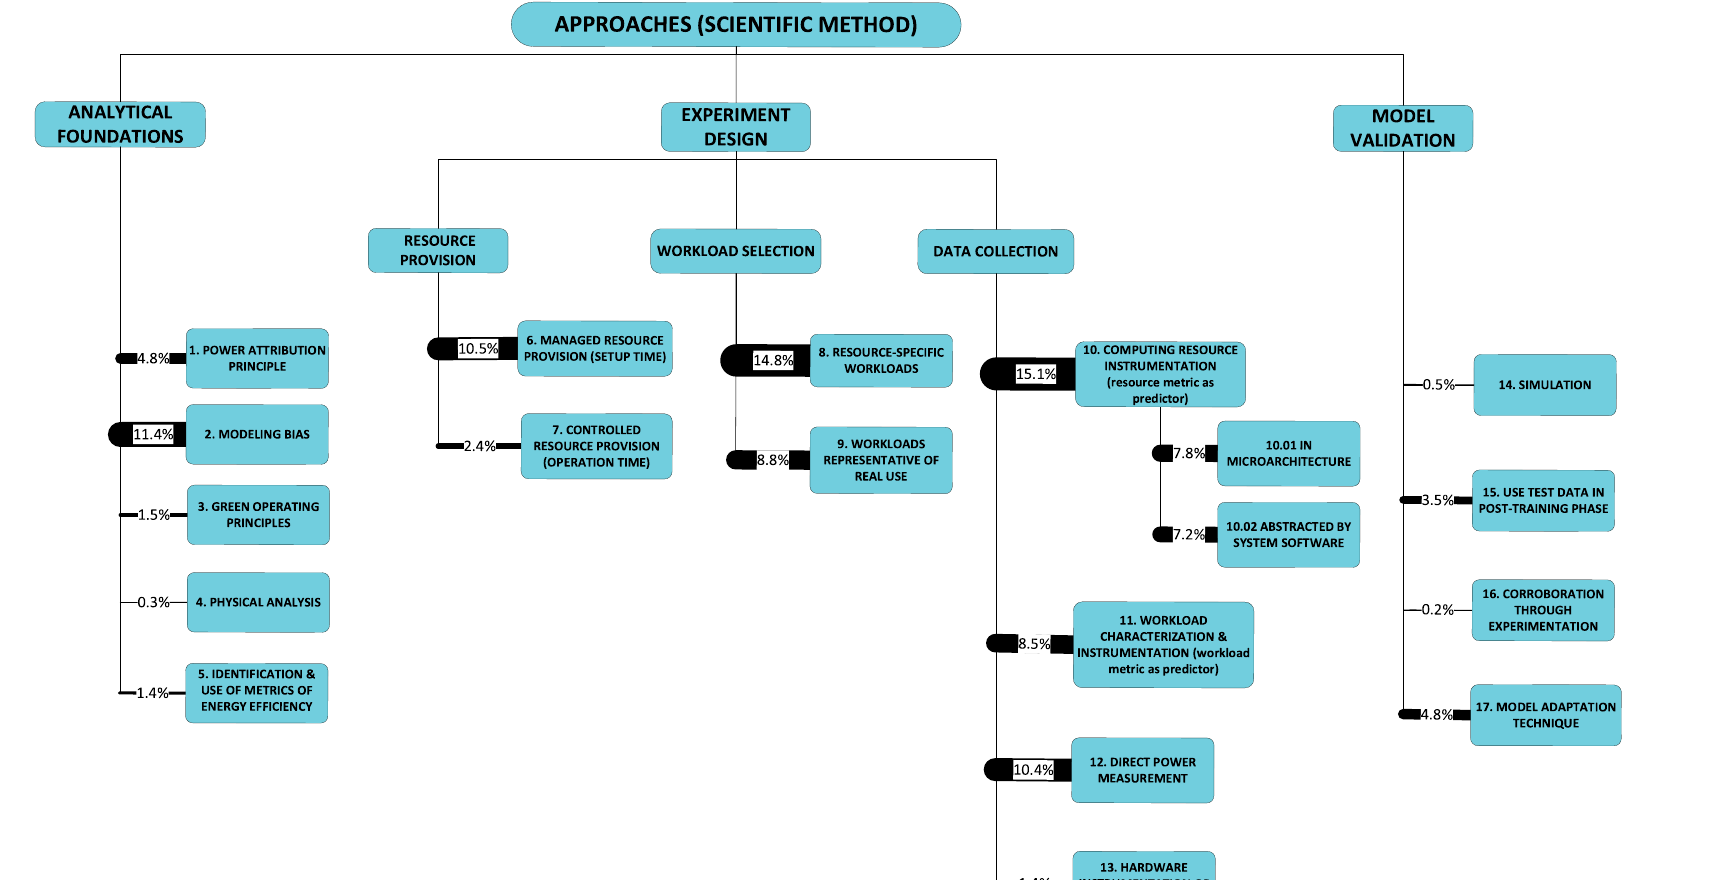
Figure 2. A taxonomy of approaches; approach utility U A